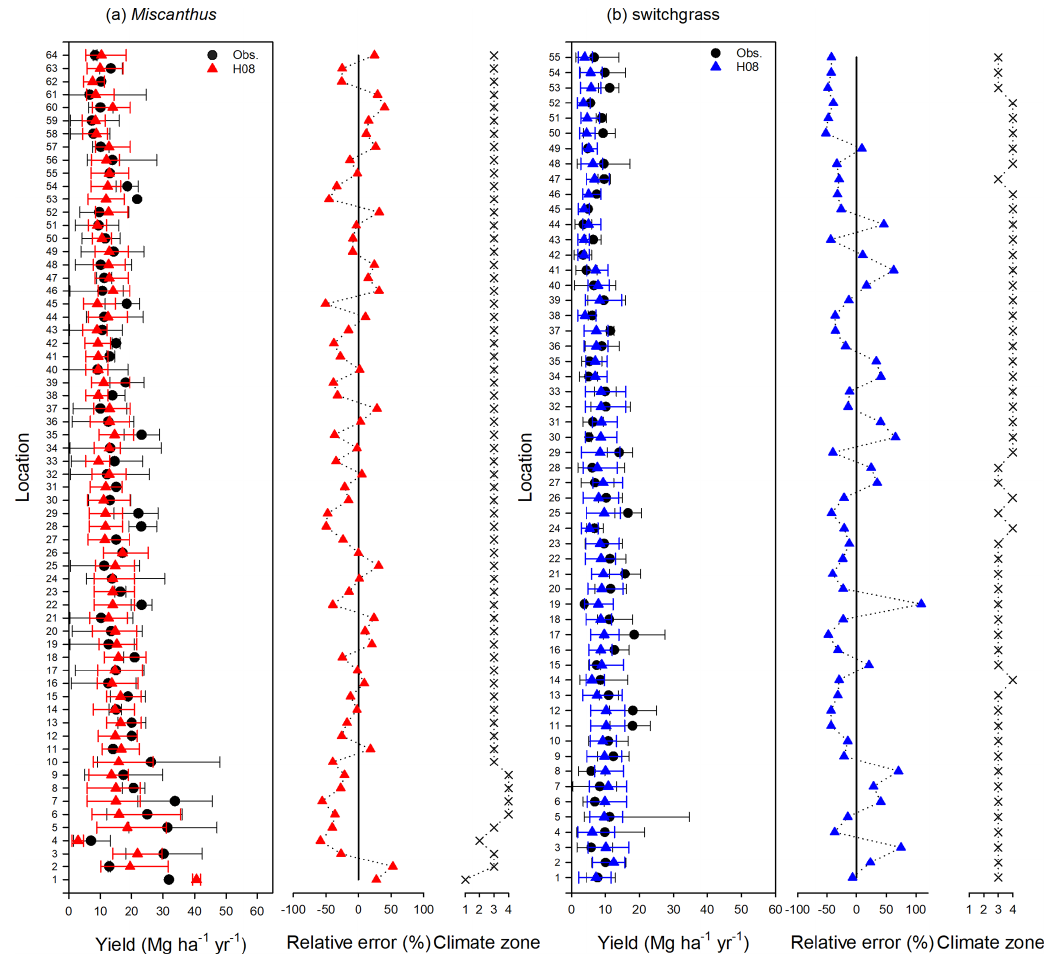
Figure 5. Site-specific performance (presented with latitude increasing from the bottom of the vertical axis) and relative error of the simulated yield obtained using the enhanced H08 model compared with the observed yields for Miscanthus and switchgrass. The longitude and latitude of each location for Miscanthus and switchgrass are given in Tables S1 and S2, respectively. The “x” indicates the site’s climate, where 1, 2, 3, and 4 refer to tropical, dry, temperate, and continental climate zones, respectively. Obs. means the observed mean yield. The black error bar represents the range of the observed minimum and maximum yield. The red or blue error bar represents the range of the simulated minimum and maximum